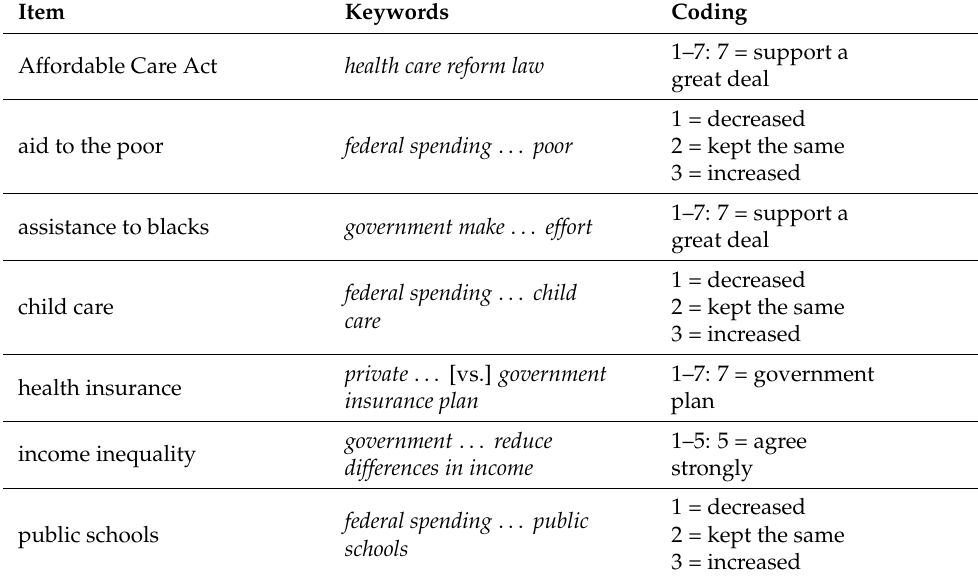
Table 1. Redistribution preference items from the American National Election Studies, 2004–2016 a .